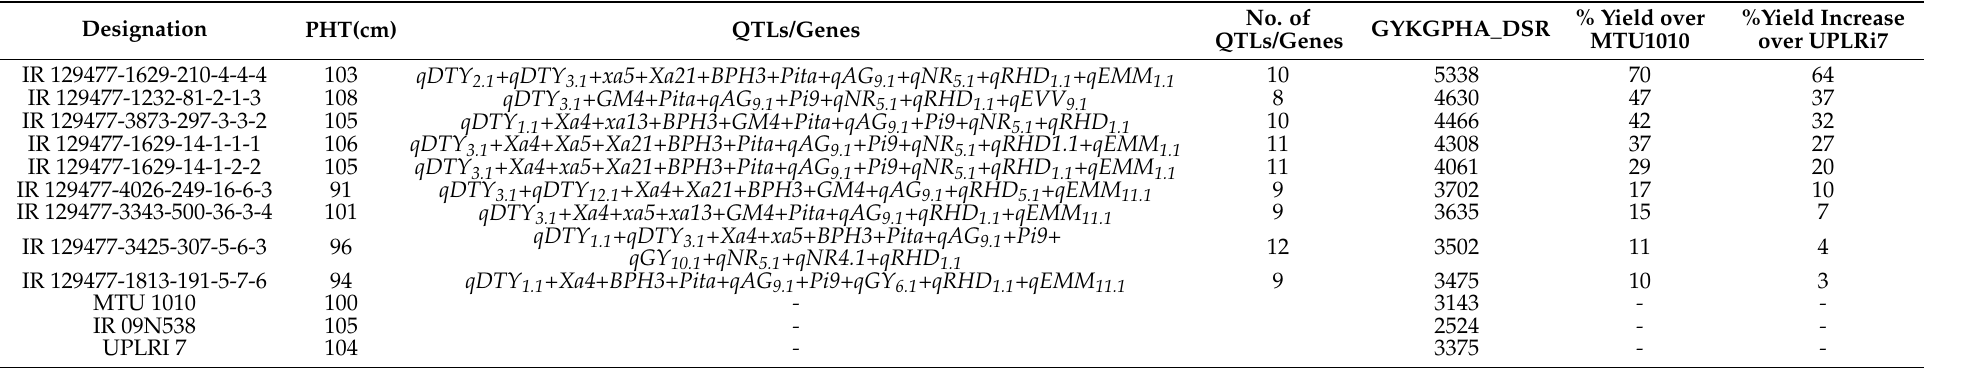
Table 7. Performance of multiple trait introgression lines over the checks under DSR